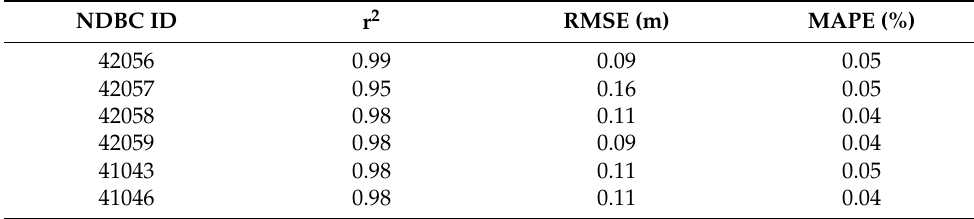
Figure 3. Scatterplots of synthetic LSTM-generated vs. NDBC-observed significant wave heights (m) for buoys ( a ) 42056, ( b ) 42057, ( c ) 42058, ( d ) 42059, ( e ) 41046, and ( f ) 41047. Table 3. Error statistics between LSTM-generated and NDBC observed significant wave